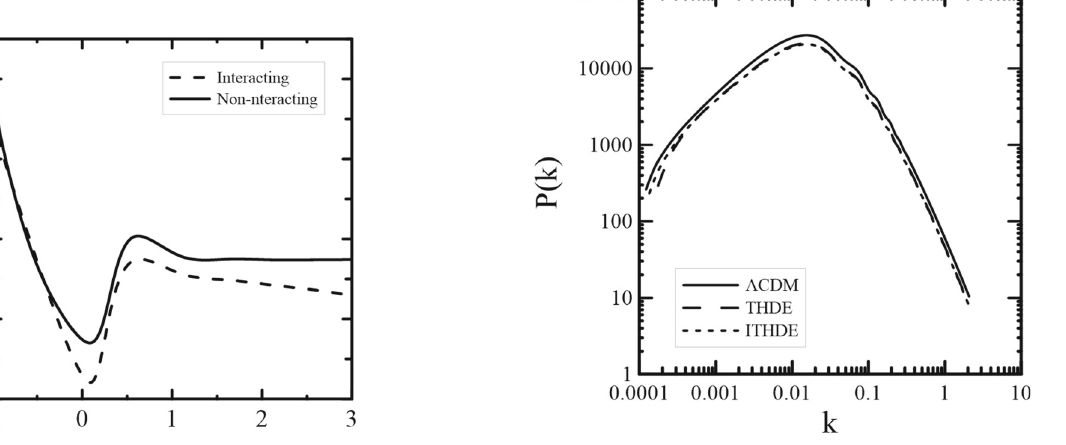
Fig. 6 The evolution of v 2 s versus redshift for the THDE model with consideration of the future event horizon as IR cutoff. Dashed line indi- cates the interacting and solid line indicates the non-interacting model according to the best fitted value of parameters listed in the Table 1. The negative value of trajectory shows the instability against perturbation of the background